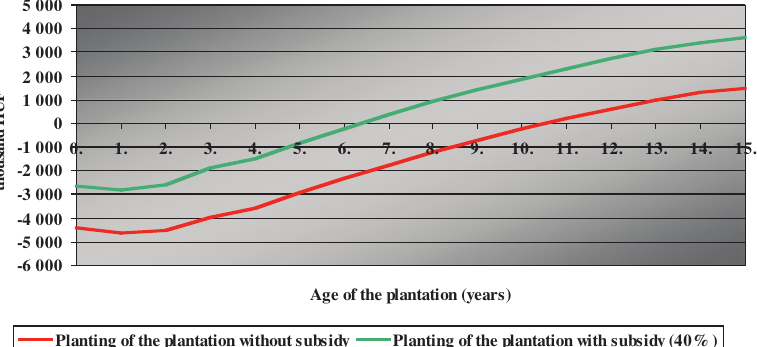
Figure 1. Profitability and the time of returns of an intensive apple plantation without hail nets and hail damages (the present net value of accumulated income (NPV), in thousand Ft/ha)